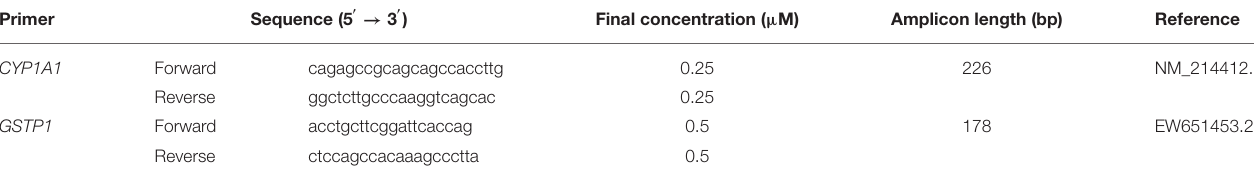
TABLE 1 | Real-time PCR primers used in this